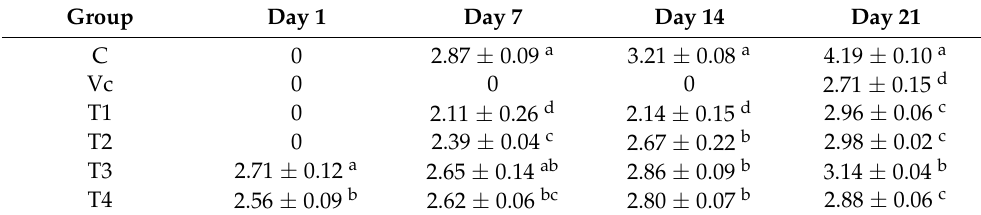
Table 6. Changes of total viable count (TVC) of frankfurters during storage (n = 6).